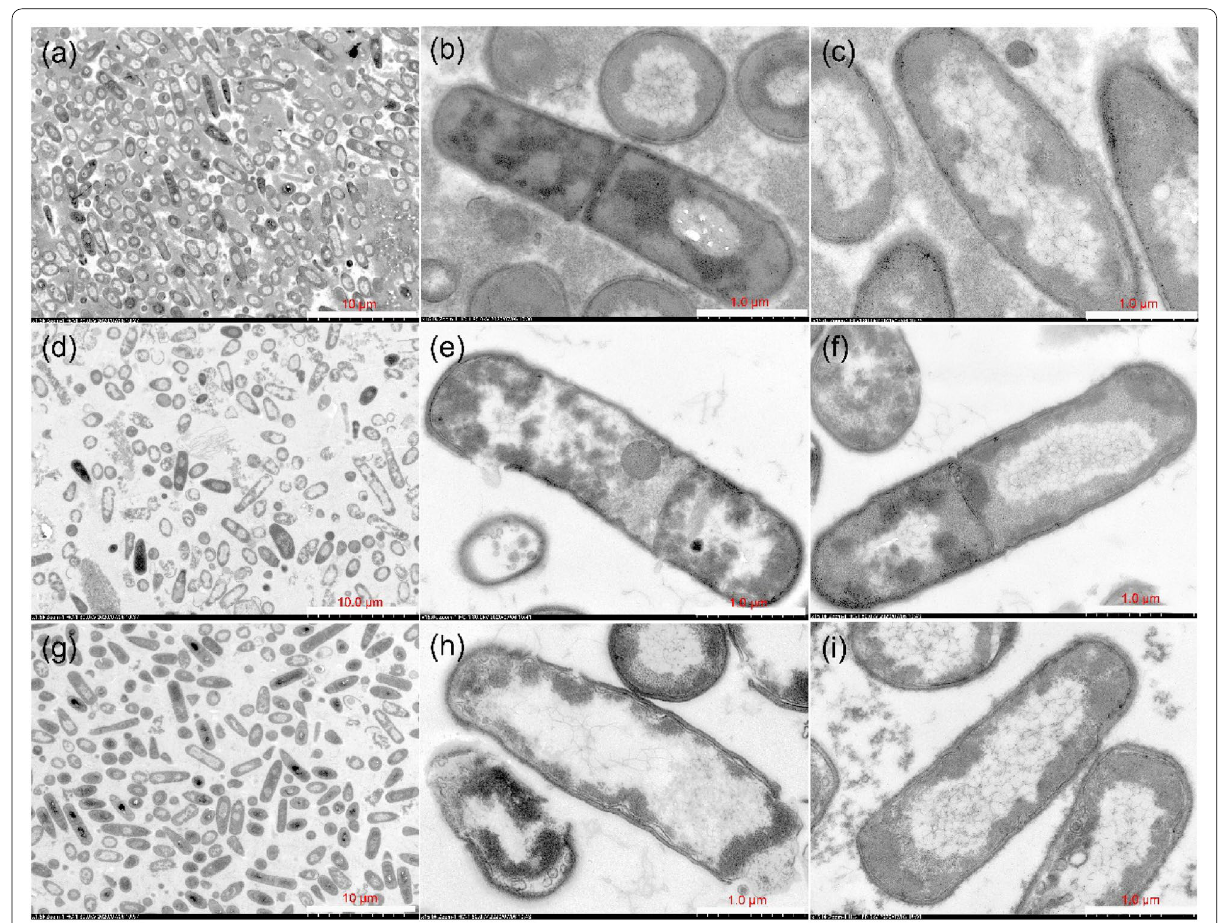
Fig. 4 TEM analysis of recombinant B. subtilis ( a – c ), recombinant E. coli ( d – f ), and co-culture of recombinant B. subtilis and E. coli ( g – i